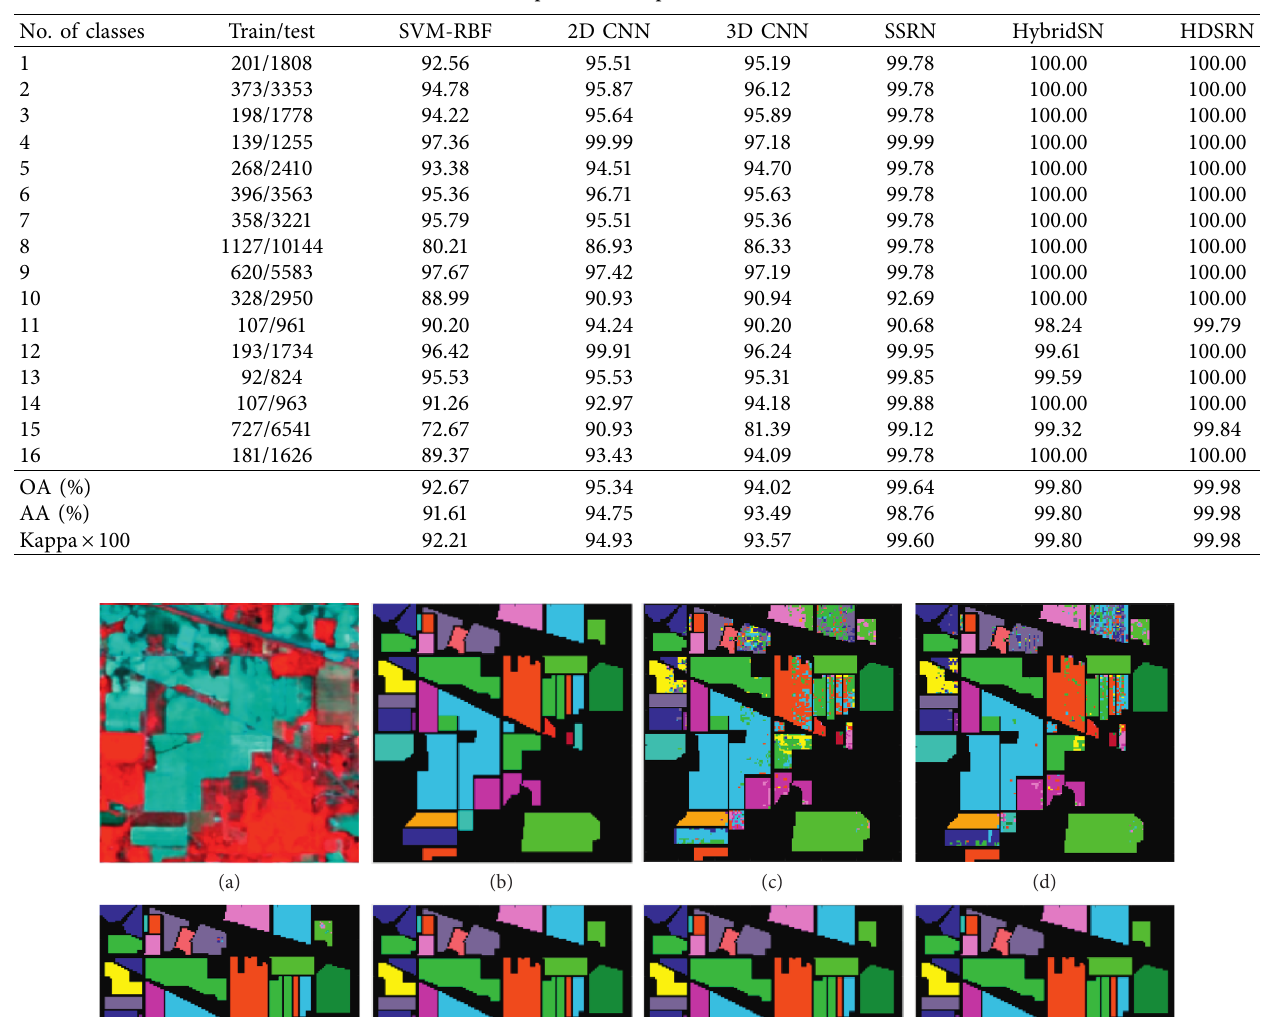
Table 10: The comparison of experiments in the SA dataset.